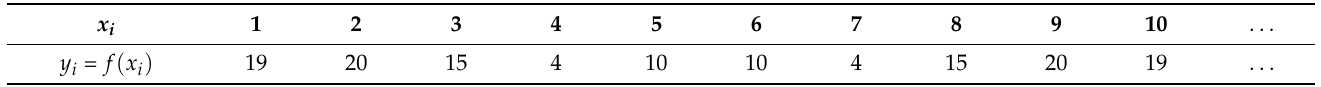
Table 3. The generated secret shares by the trusted G.M over the polynomial f ( x ) = 12 + 10 x + 20 x 2